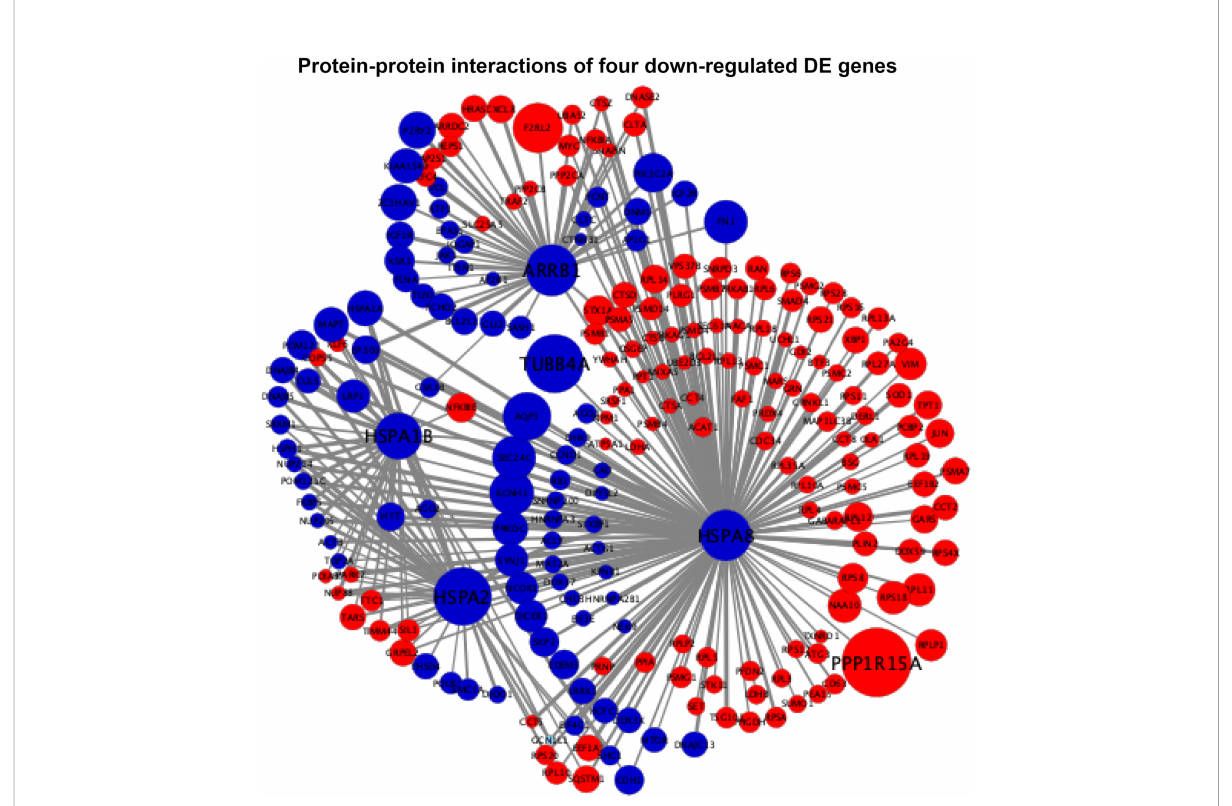
FIGURE 5 Protein – protein interaction (PPI) networks of four extremely downregulated differentially expressed genes ( HSPA8 , HSPA2 , HSPA1B , and ARRB1 ). The circles indicate the nodes (genes) with the edges that are solid lines indicating the interaction scores of PPIs. The sizes of circles indicate the values of |log 2 (FC)|, while the red and blue colors indicate the upregulated and downregulated statuses,